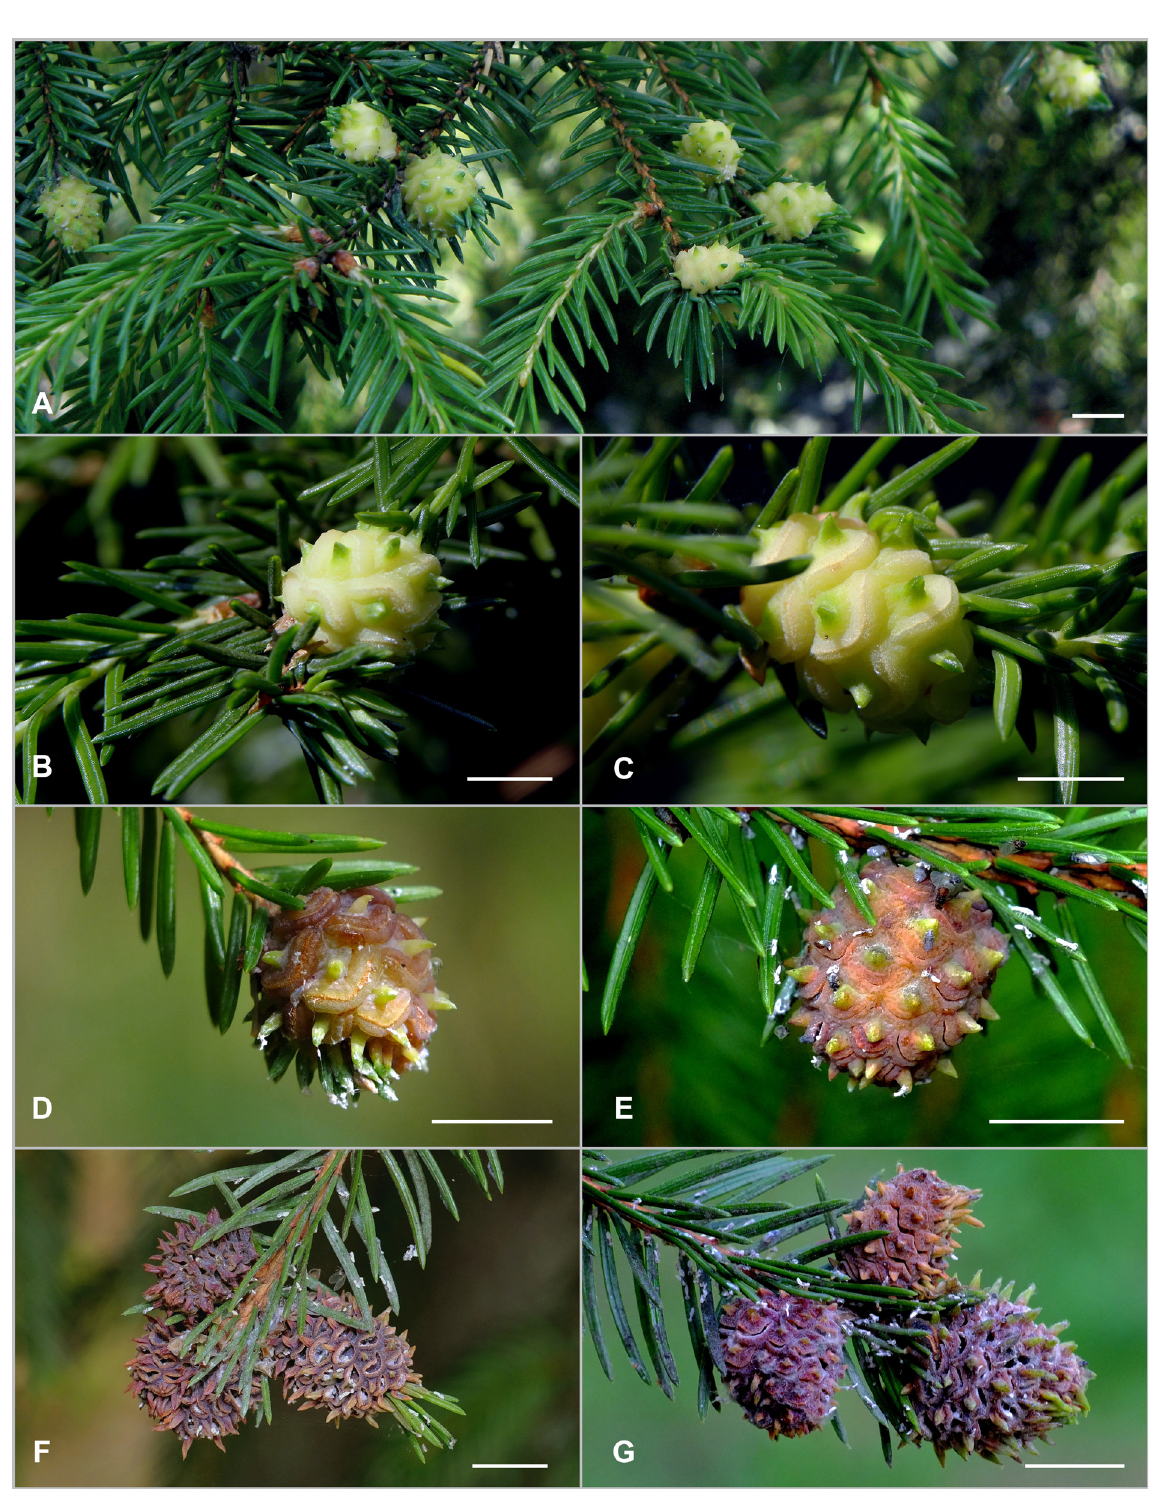
Fig. 10. Adelges (Adelges) tardus (Dreyfus, 1888). Galls on Picea abies . A–B . Almost full-grown. C . Almost mature. D–E . Mature, first gallicolae have emerged. F–G . Fully opened galls. Scale bars: 10